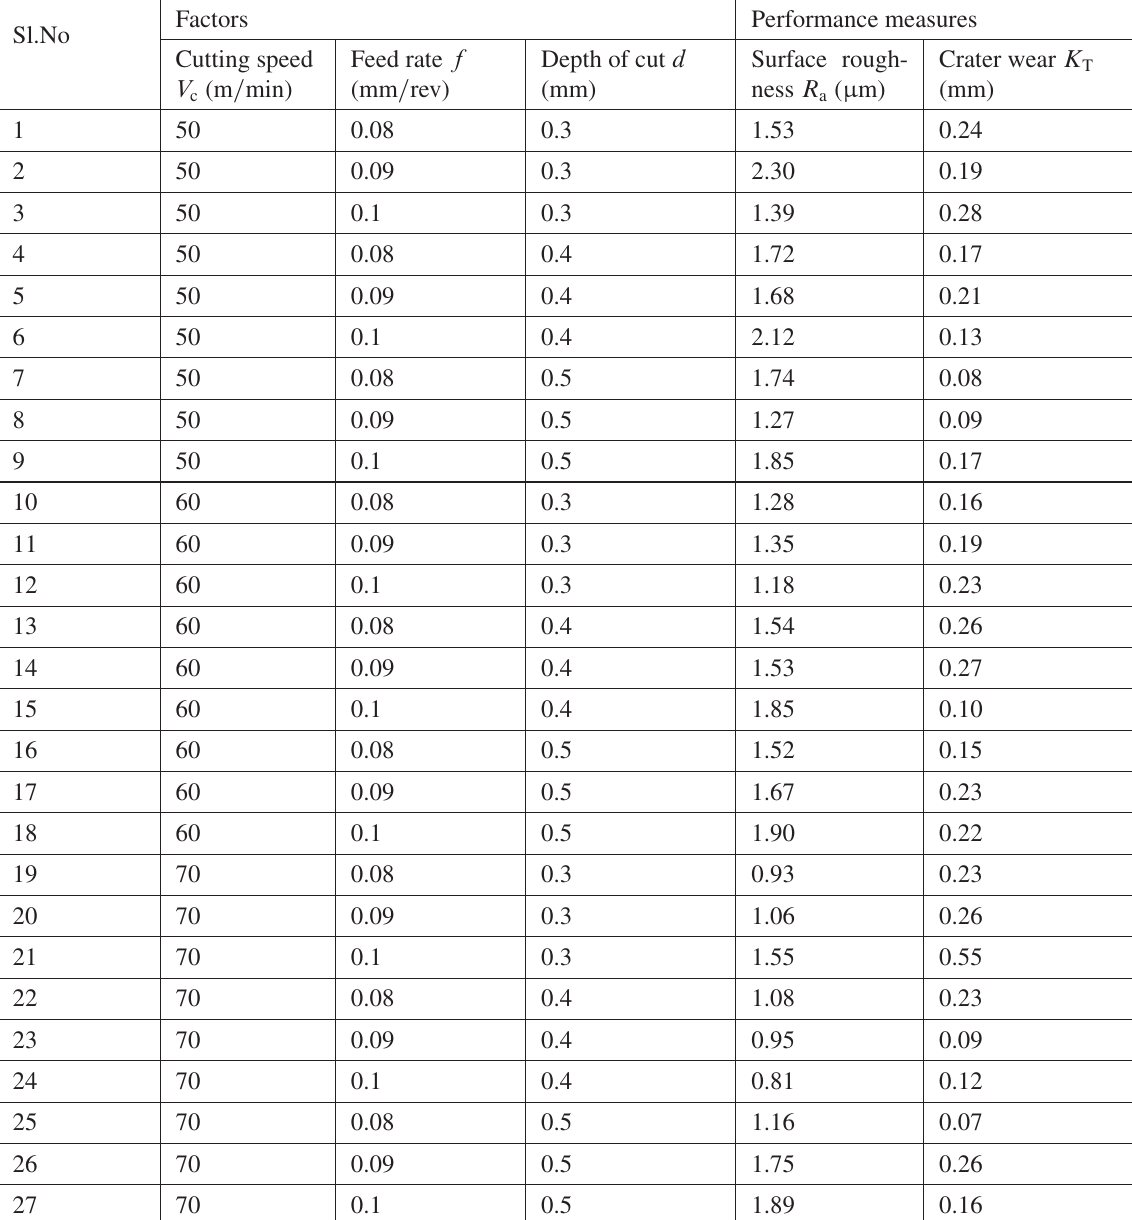
Table 2. Design layout and experimental results for crater wear and surface roughness criteria. Sl.No.